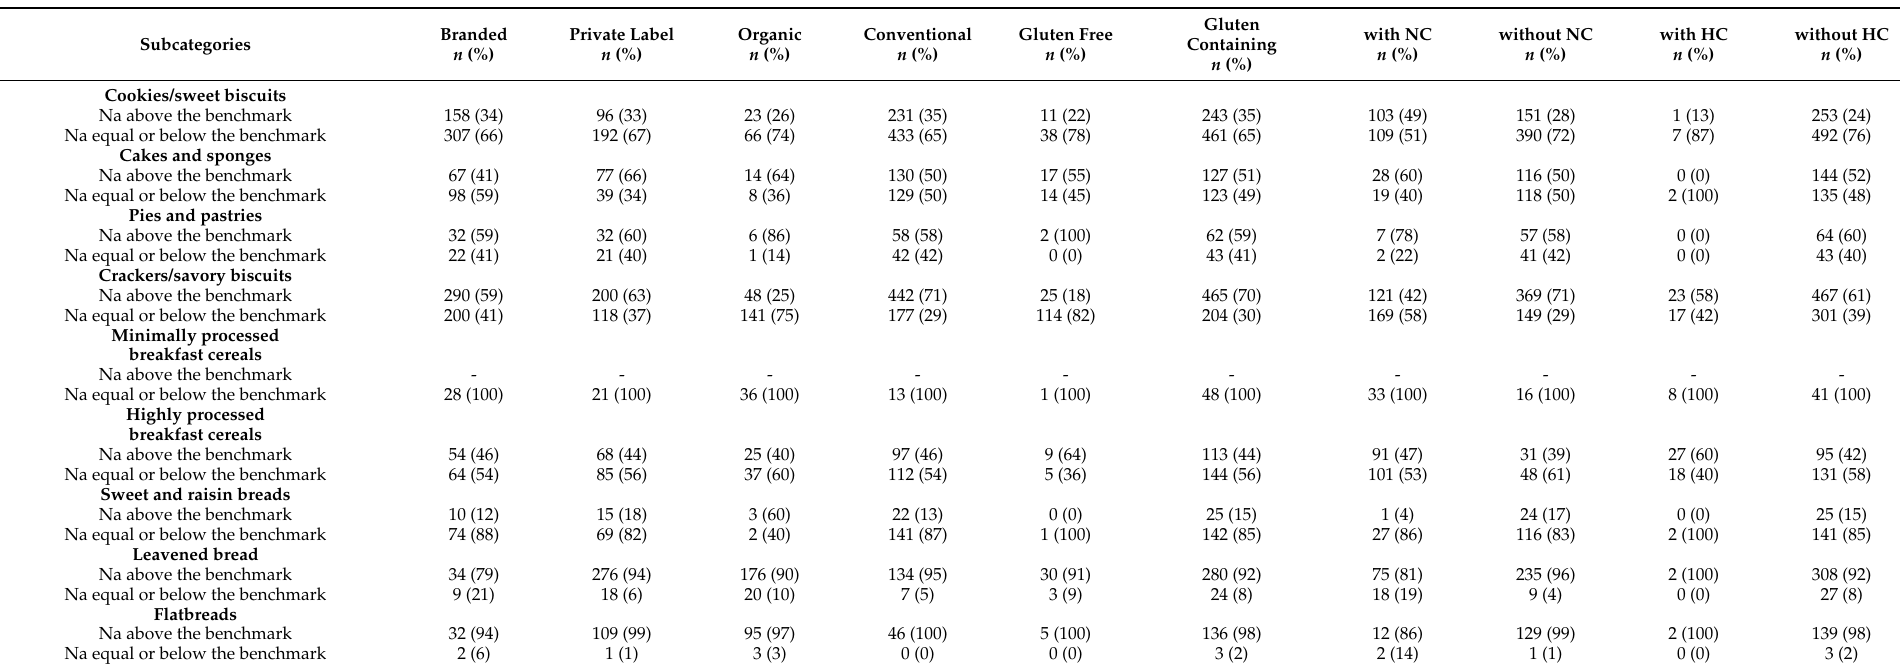
Table 2. Number and percentages of the cereal-based products with sodium content equal or below and above to the relative benchmarks, grouped for the presence of other declarations on the food